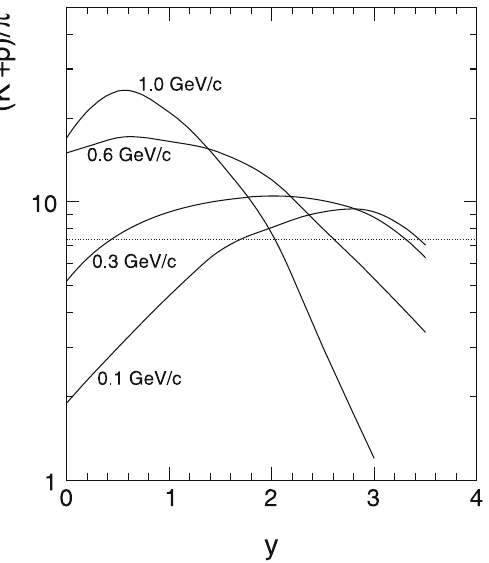
Fig. 6 (K − +p)/ π − ratio as a function of rapidity for different p T for √ s = 17 . 2 GeV, compared to the mean ratio at the NA49 data at